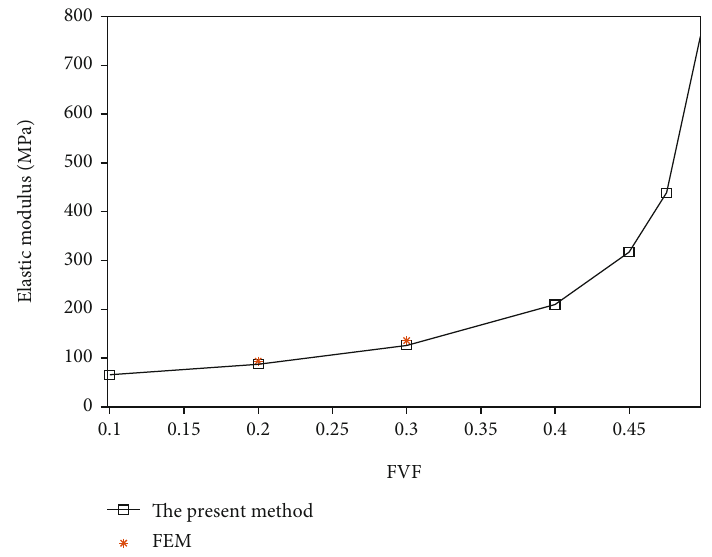
Figure 3: A comparison of elastic modulus E